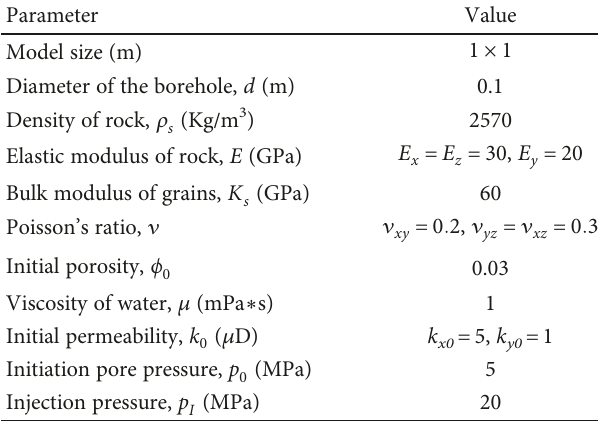
Figure 6: Geometry model for water permeation into anisotropic porous medium. Table 4: Computational parameters for anisotropic water permeation.